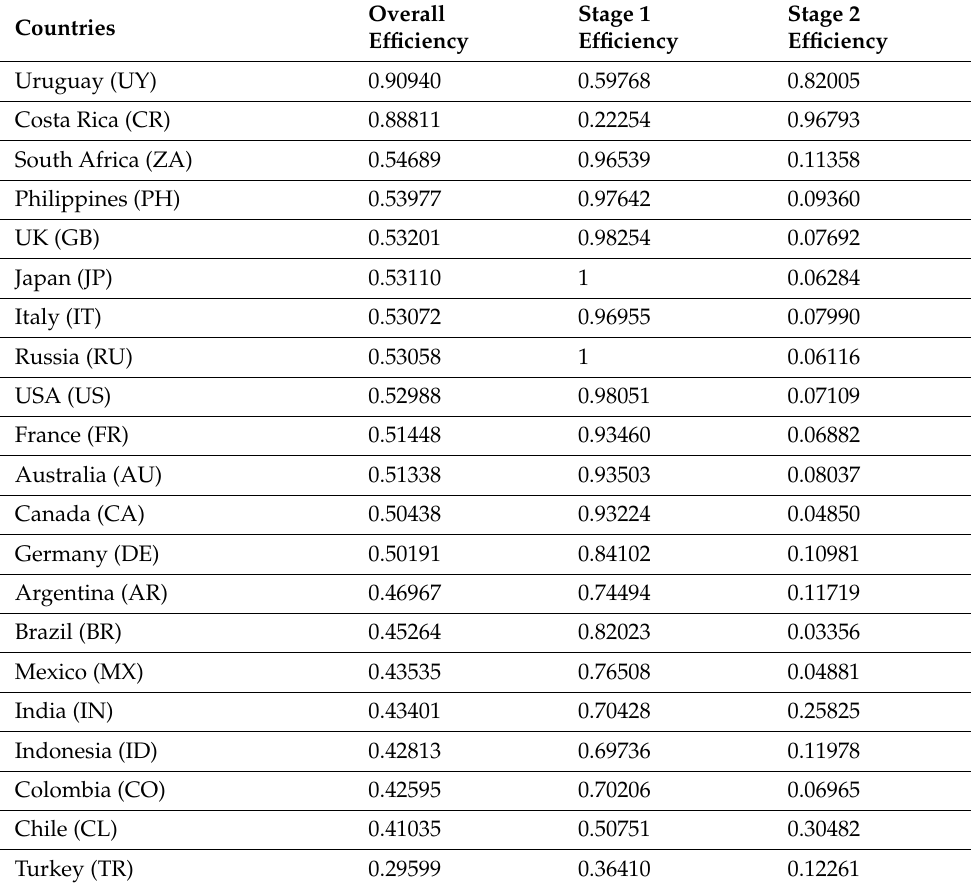
Table 7. Anti-corruption efficiency in